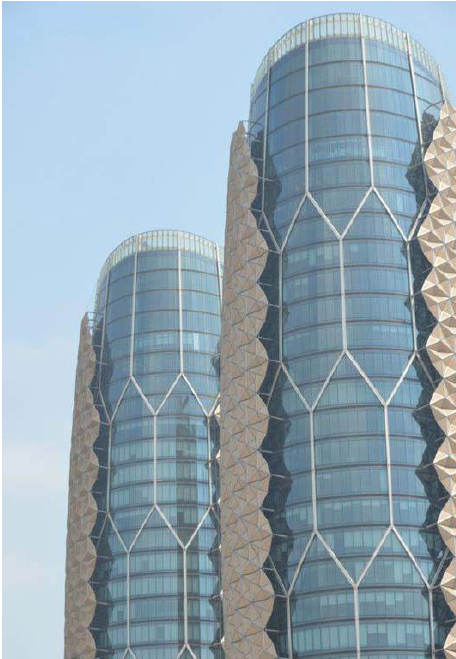
Figure 13. Al Bahr Towers (courtesy of Terri Meyer